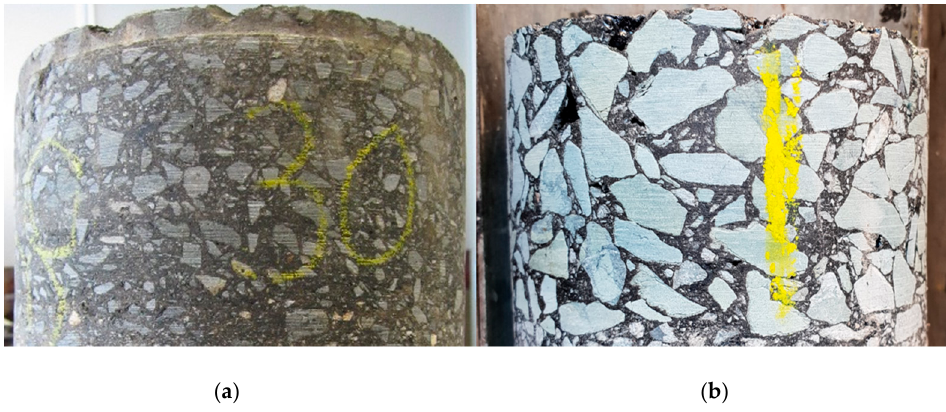
Figure 1. Core samples of ( a ) dense graded asphalt (DGA) and ( b ) stone mastic asphalt